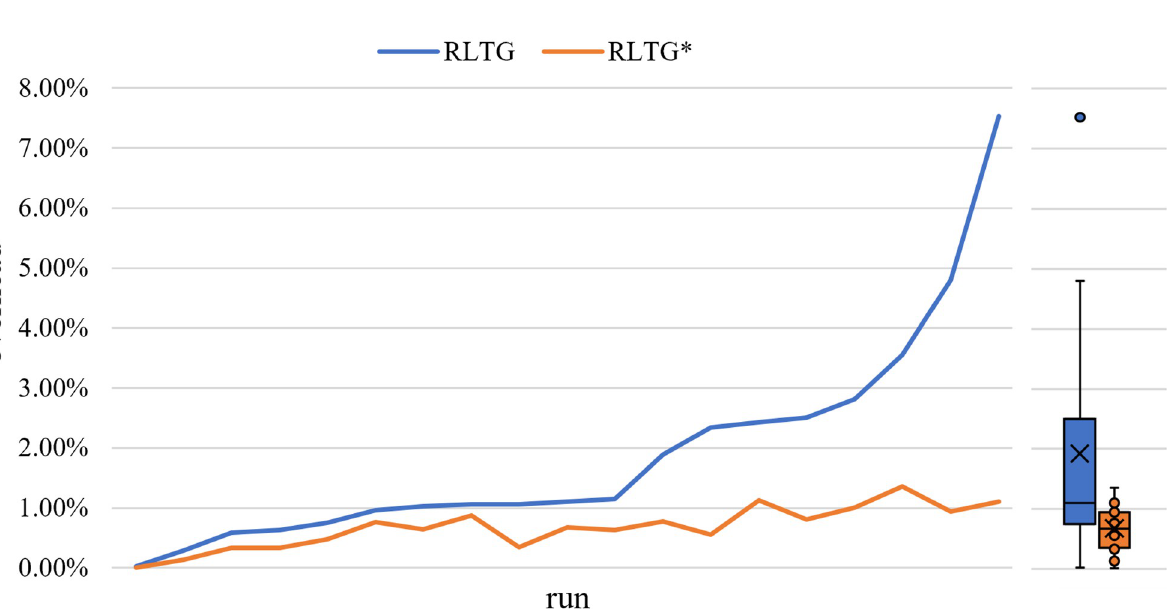
Fig 6. Overhead of RLTG compared to RLTG+ on benchmark. The x-axis represents each program in the benchmark. The y-axis represents the difference in the number of testcases executed per second between RLTG and RLTG+ as a percentage of the number of testcases executed per second in